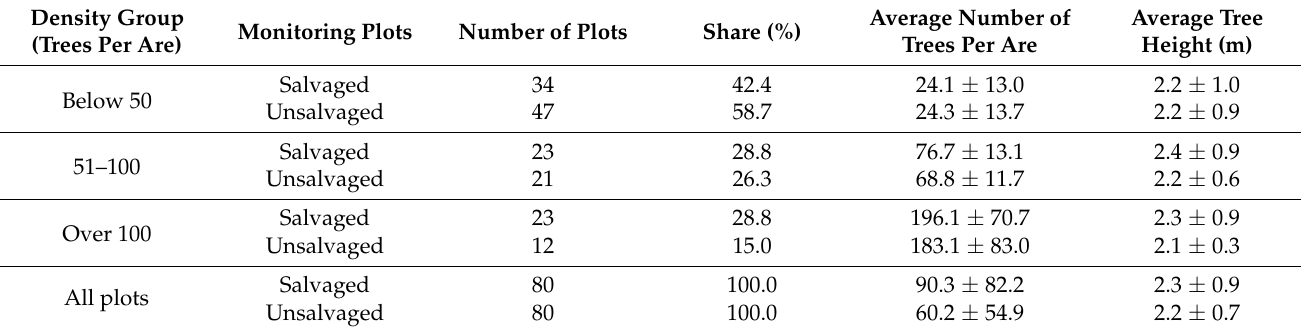
Table 3. Share of salvaged and unsalvaged monitoring plots grouped with regard to tree density and their average number (± standard error; the High Tatra Mts. in 2019). Density Group (Trees